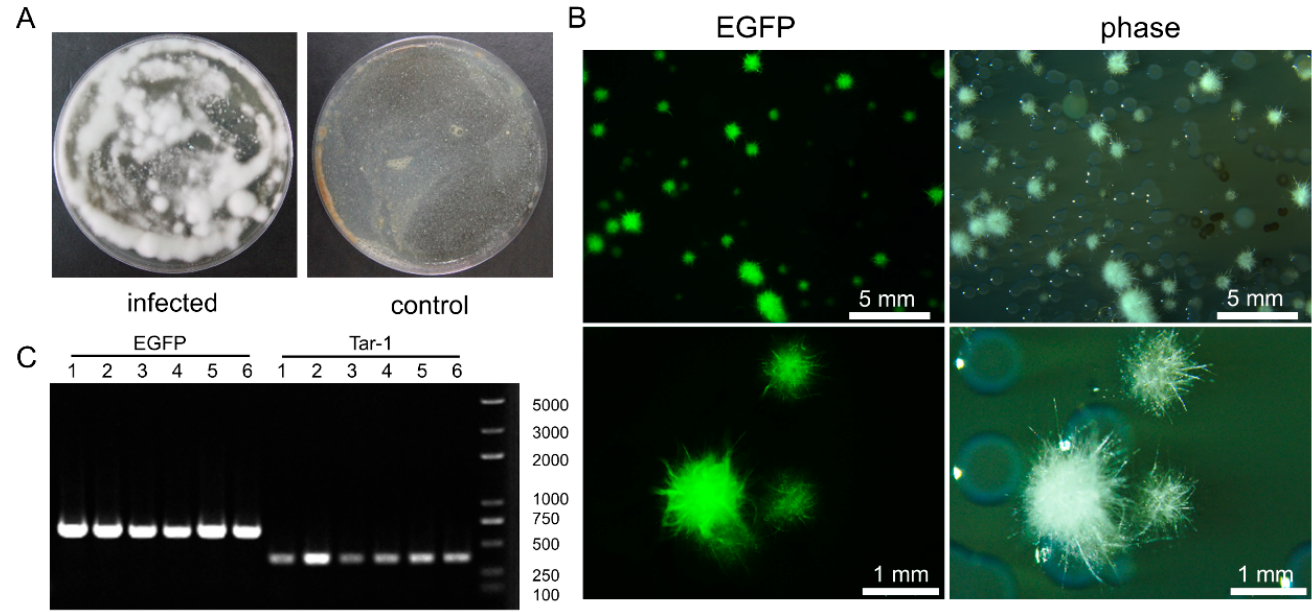
Figure 4. C. farinosa detection in the excrement of T. armoricanus larvae. ( A ) Microbial cultures of the